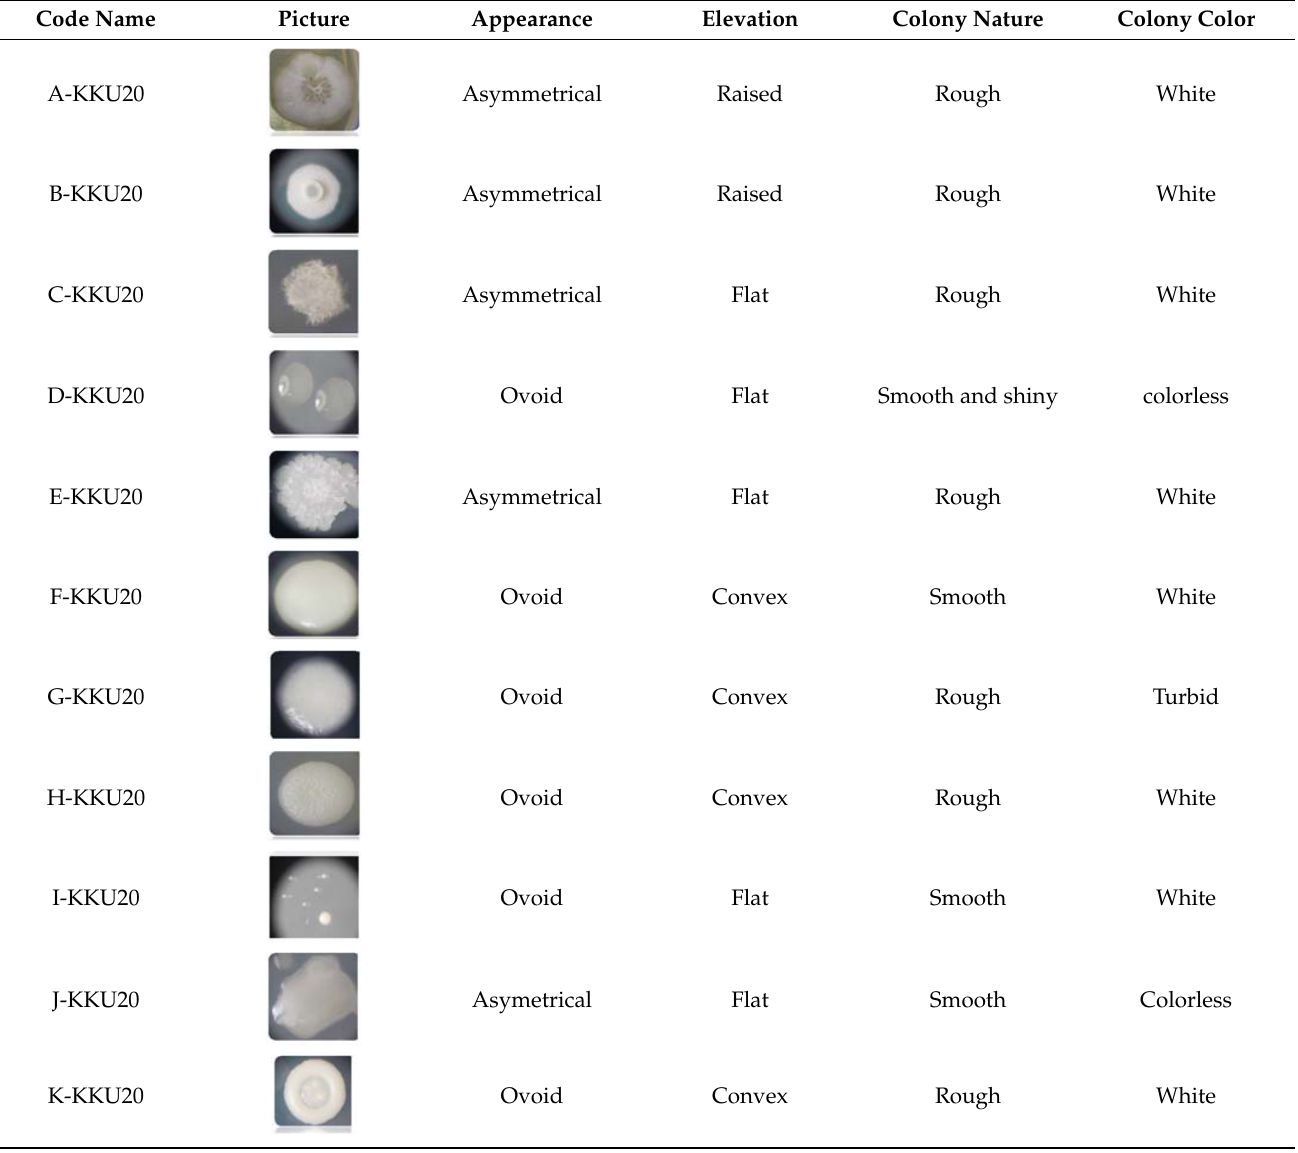
Table 1. Colonies morphology of ruminal yeast strains of Thai-Holstein-Friesian.